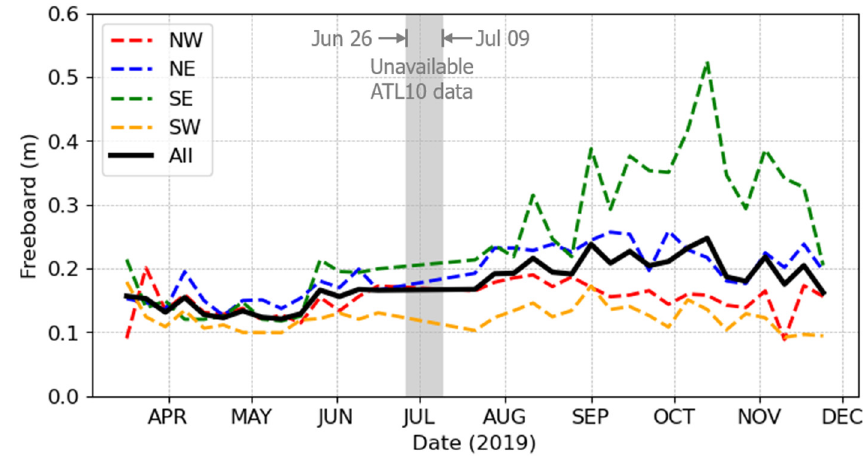
Figure 9. Weekly variations of the average freeboards for the four sectors in the Ross